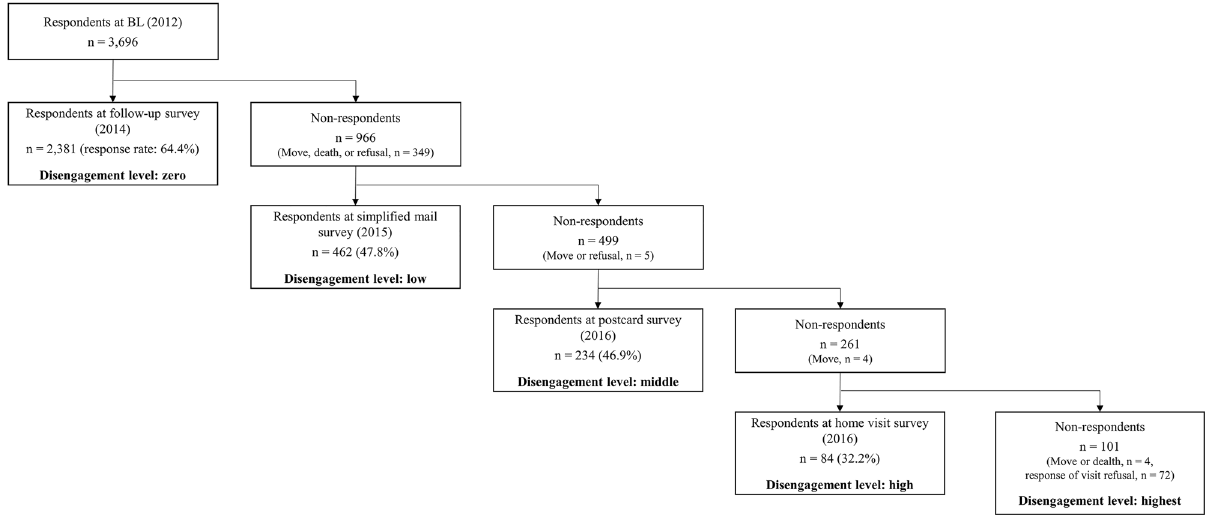
Figure 1. Flow diagram of inclusion and exclusion of participants and stratification by societal disengagement